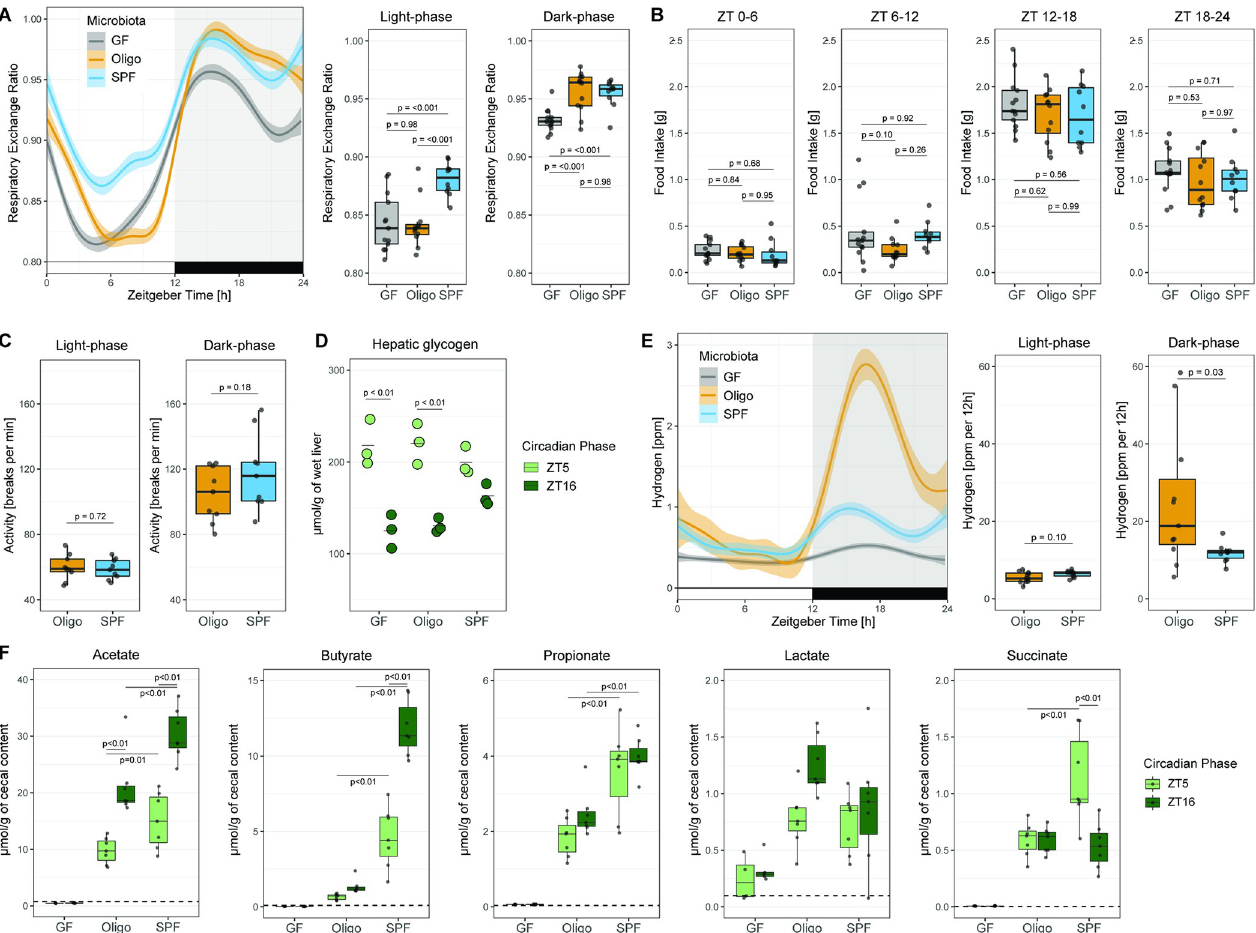
Fig 3. Circadian changes in RER, microbiota-derived hydrogen, and SCFAs. (A) Comparison of circadian changes in RER among GF, OligoMM12, and SPF C57B6/J mice. RER curves obtained by smoothing function of data obtained every 24 min per mouse over 10 d. Mean RER during the light phase (Zeitgeber 0–12) and dark phase (Zeitgeber 12–24). (B) Cumulative food intake during described ZT periods. Mice included in this analysis are those that underwent long-term indirect calorimetry, and they are a subset of the mice represented in Fig 2F. (C) Locomotor activity, average light phase and dark phase breaks/ minute daily. (D) Hepatic glycogen and triglyceride concentration in samples obtained at Zeitgeber 5 and 16 ( N = 3 per group). (E) Hydrogen production, curves obtained by smoothing function of data obtained every 24 min per mouse. Area-under-curve after regression-based normalization by cecal mass during the light and dark phase (N of mice per group: OligoMM12 = 11, SPF = 10). (F) Concentration of SCFAs (acetate, butyrate, propionate) and intermediate metabolites (lactate, succinate) products in cecal content during the light phase (ZT5: GF = 4, OligoMM12 = 7, SPF = 7 mice) and dark phase (ZT16: GF = 5, OligoMM12 = 7, SPF = 7 mice). Number of mice per group in all figures unless otherwise specified: GF = 13, OligoMM12 = 12, SPF = 10. p -values obtained by Tukey’s honest significance test. Data underlying this figure are supplied in S1 Data. GF, germ-free; RER, respiratory exchange ratio; SCFA, short-chain fatty acid; SPF, specific-opportunistic-pathogen-free; ZT, Zeitgeber